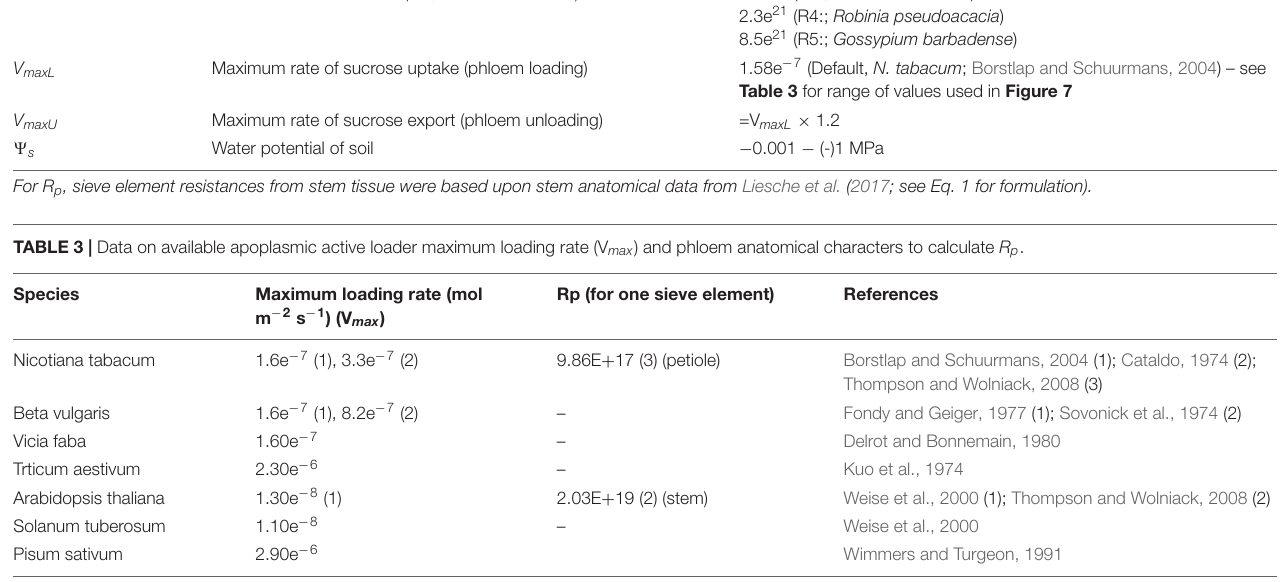
Table 2 for the parameters varied across